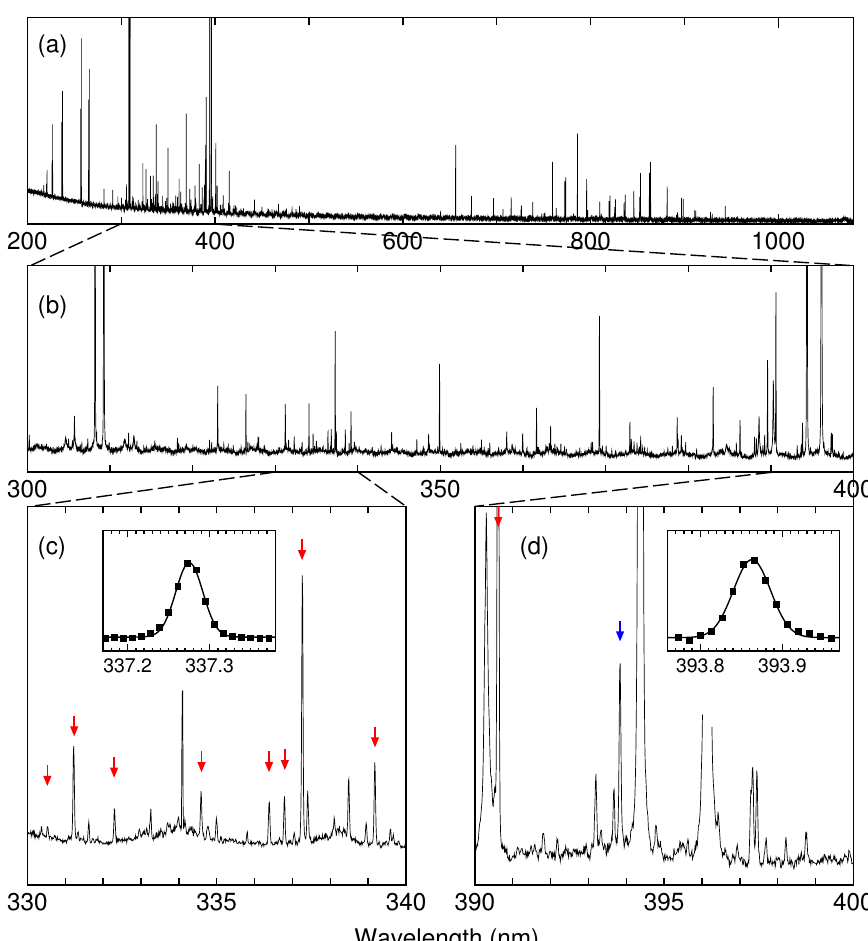
Figure 2. LIBS spectrum obtained for an Al-5 wt% Er alloy target in an Ar atmosphere for the ( a ) whole spectrometer (200–1080 nm), ( b ) 300–400 nm, ( c ) 330–340 nm, and ( d ) 390–400 nm regions.